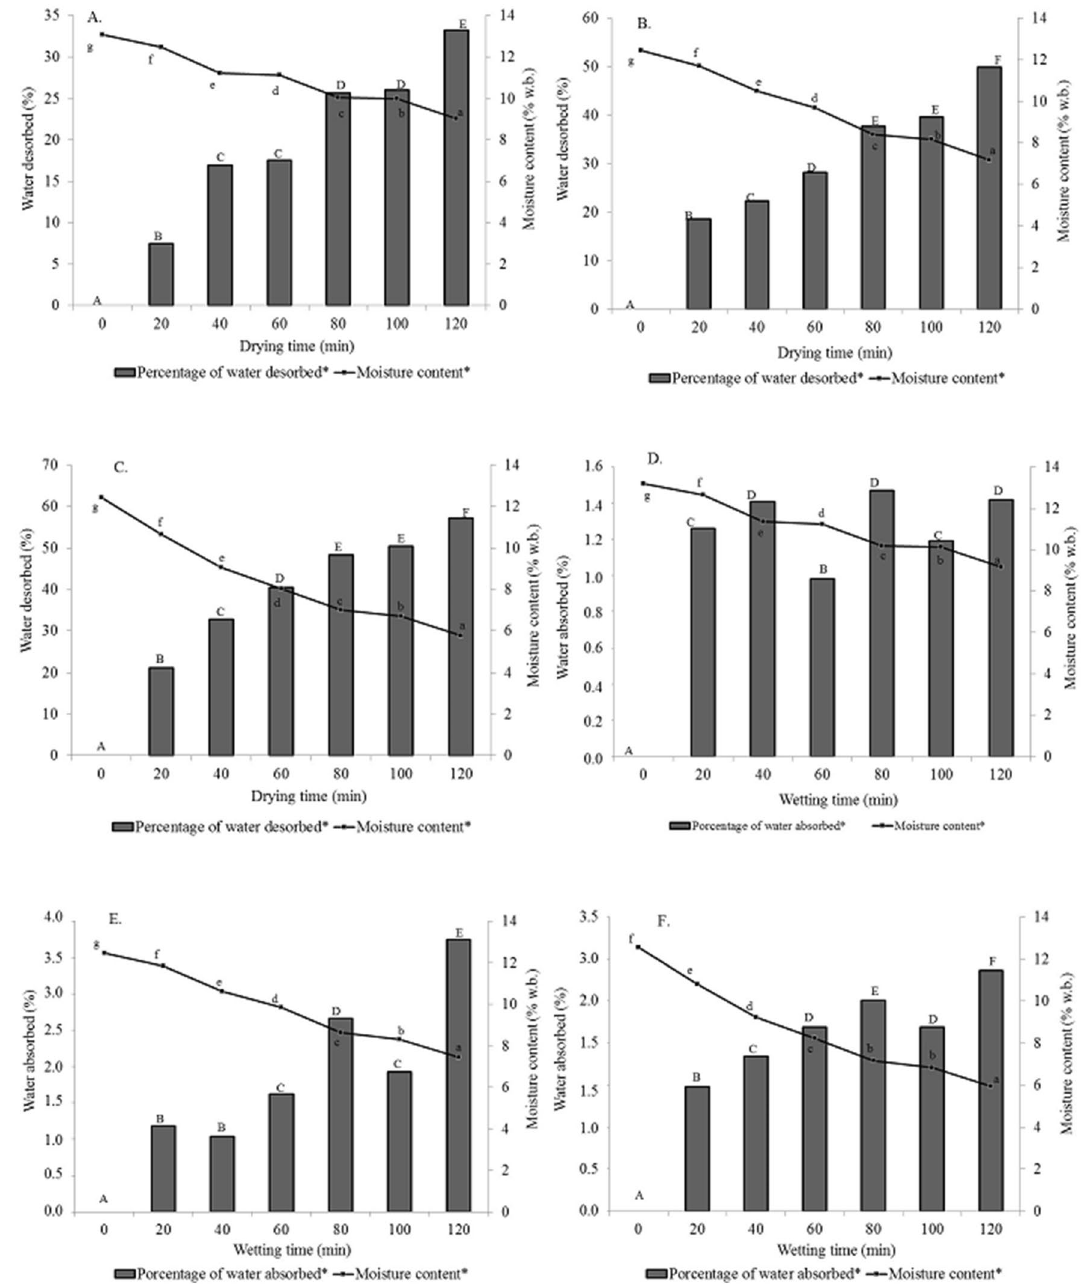
Figure 2. Variations in moisture content—desorbed and absorbed water during the drying and wetting procedures: ( A , D ) 80, ( B , E ) 100, and ( C , F ) 120 °C. *Significant at a probability of 5% in the Tukey